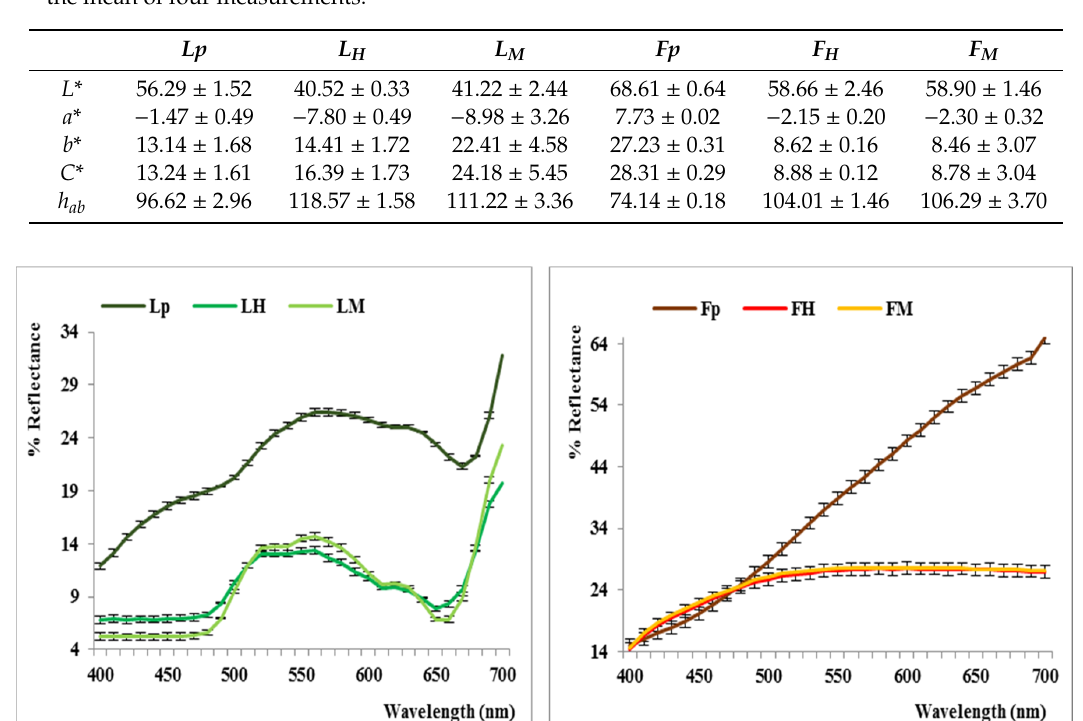
Table 1. Colorimetric CIEL*a*b * parameters of Elaeagnus powders and extracts; each reported value is the mean of four measurements.